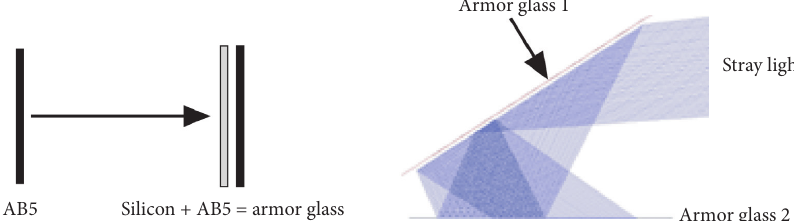
Figure 10: Design of stray light trap. The pair of absorbers forms the stray light trap. Among them, the first absorber needs to form an angle of nearly 30 ° with the incident stray light to ensure that the position of the second absorber can be as close to the first absorber as possible. At the same time, the light near the normal direction enters the second absorber and then reflects back to the first absorber.